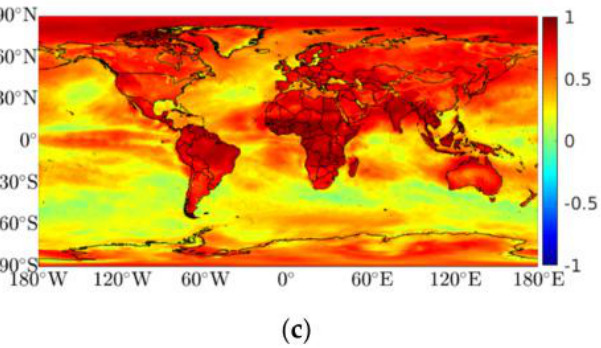
Figure 5. Comparison of 1 year (2020) of ERA5 RH (modeled from surface dew point temperature, pressure, and temperature) with HGPT2 RH; ( a ) mean RMSE values (in %); ( b ) mean bias values, positive (negative) values indicate an overestimation (underestimation) of the HGPT2 model (in %); and ( c ) mean Pearson correlation coefficient